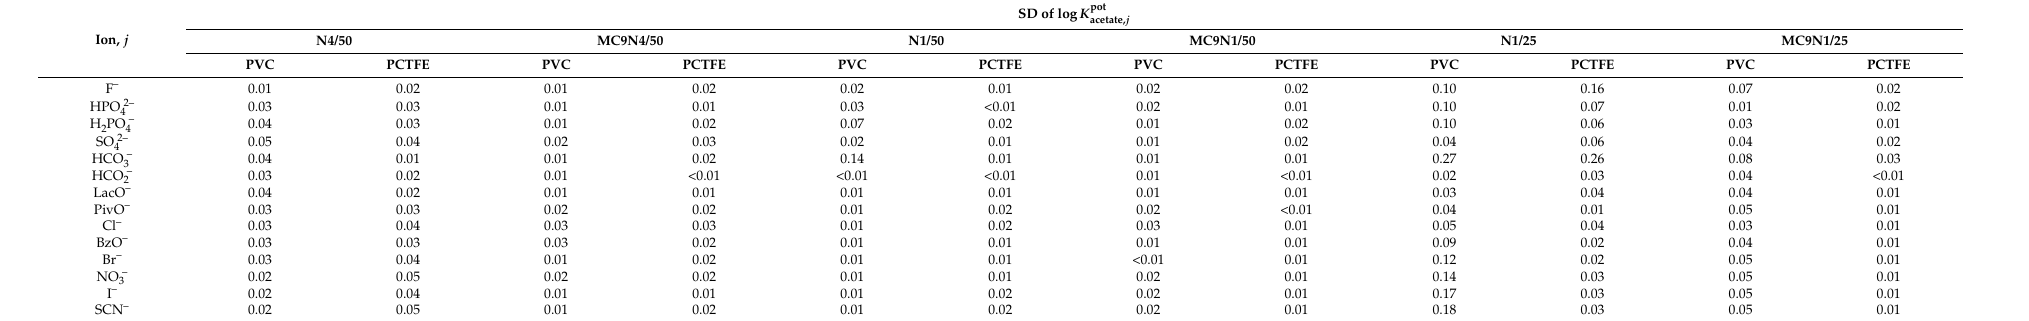
Table A12. Standard deviations for the average selectivity coefficients in Table A11. The number of measurements and the number of sensors were n = 1 and k = 3, respectively. See Table 1 for membrane